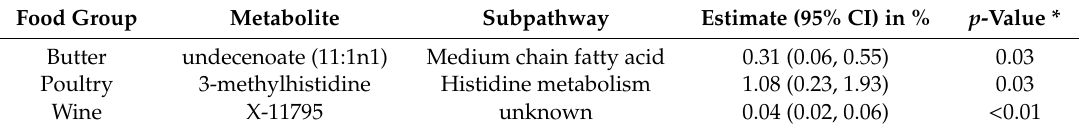
Table 3. Confirmed food-metabolite associations for the food groups butter, poultry, and